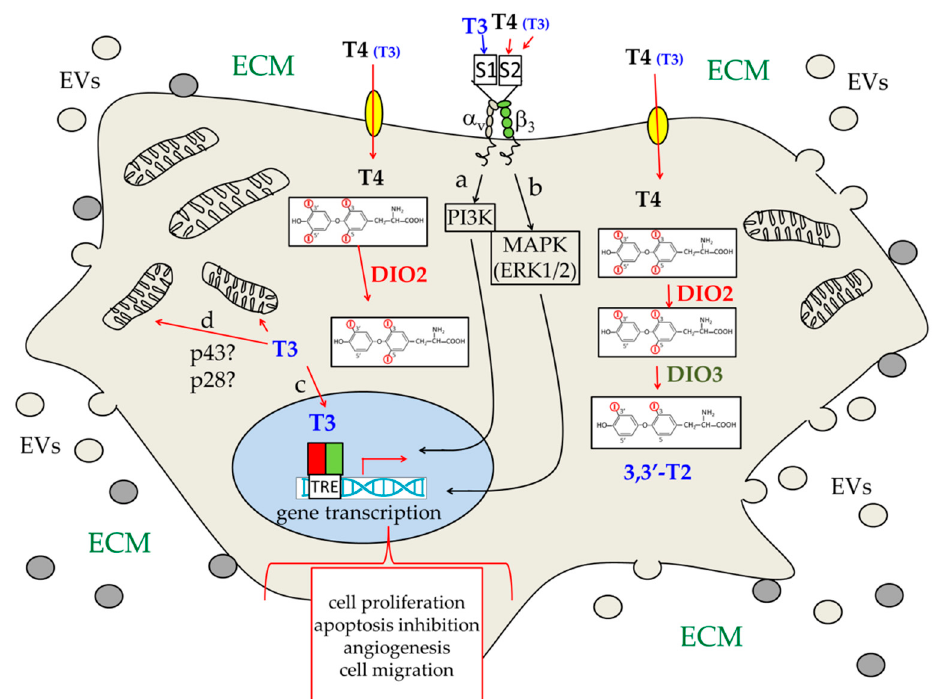
Figure 5. Schematic view of the different hypothetical pathways triggered by THs in a generic brain cancer cell. THs can enter the cells through membrane transporters (yellow ovals), such as MCT8 and OATP1C1. They can also bind to plasma membrane receptors, the best known of which is α v β 3 integrin. T4 is the main form of circulating THs, and thus the main form present in the extracellular matrix (ECM). As a consequence, T4 is also the most abundant TH that enters the cell, and that is able to bind α v β 3 integrin, at the level of the S2 site (red arrow). T3 is much less concentrated outside the cell but can specifically bind to α v β 3 integrin at the level of the S1 site (blue arrow); it can also bind to the S2 site (red arrow), even if it is with much lower affinity than T4. Binding of T3 to the S1 site elicits a signal transduction pathway (a), which involves the phosphoinositide-3-kinas3 (PI3K). On the other hand, binding of T4 (T3) to the S2 site elicits activation of the MAPK/ERK1/2 pathway (b) [99–106]. T4 that enters the cell is converted to T3 by deiodinase 2 (DIO2). T3 can then enter the nucleus (c) and regulate transcription of target genes both directly, by binding to THRs, and indirectly, by interacting with other regulatory proteins [37,67,89]. The a-c regulatory pathways can all influence, directly or indirectly, the transcription of genes involved in different hallmarks of cancer. In addition, T3 has been suggested to be able to directly regulate mitochondrial activities (d), probably by interacting with ∆ α 1 proteins, such as p43 and p28 [37,65,66,107–109]. Finally, as schematically described in Figure 4, brain cancer cells also release extracellular vesicles (EVs; small light brown circles), which can influence other brain cells in the environment, and also receive EVs from the surrounding cells (grey small